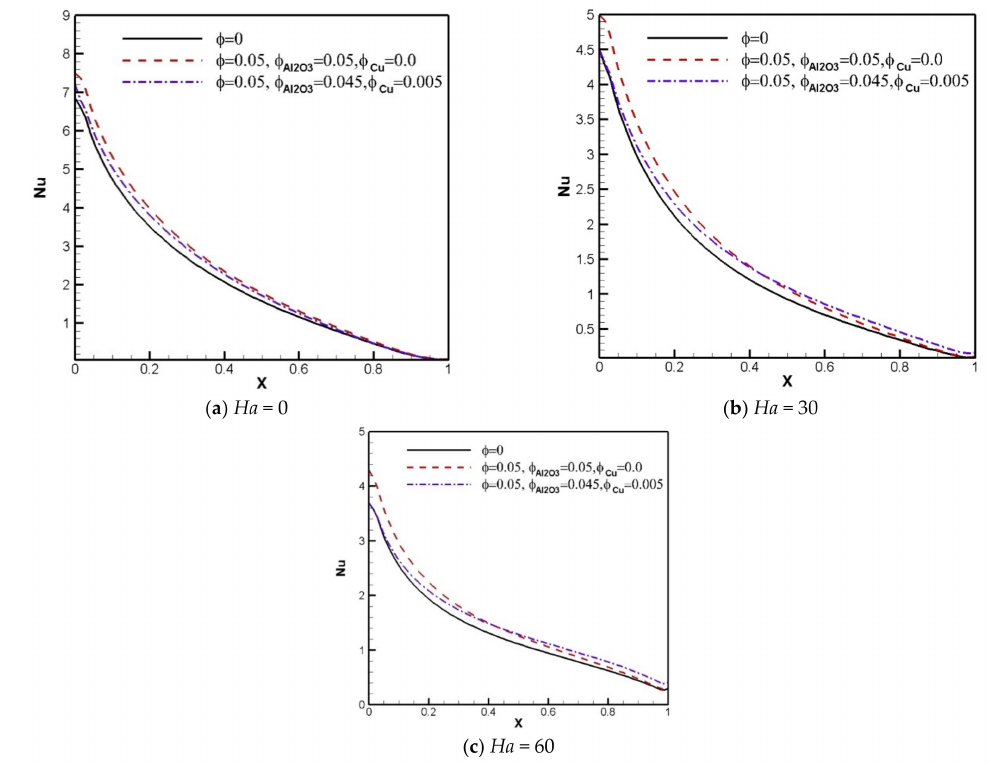
Nanomaterials 2021 , 11 , x FOR PEER REVIEW 12 of 14